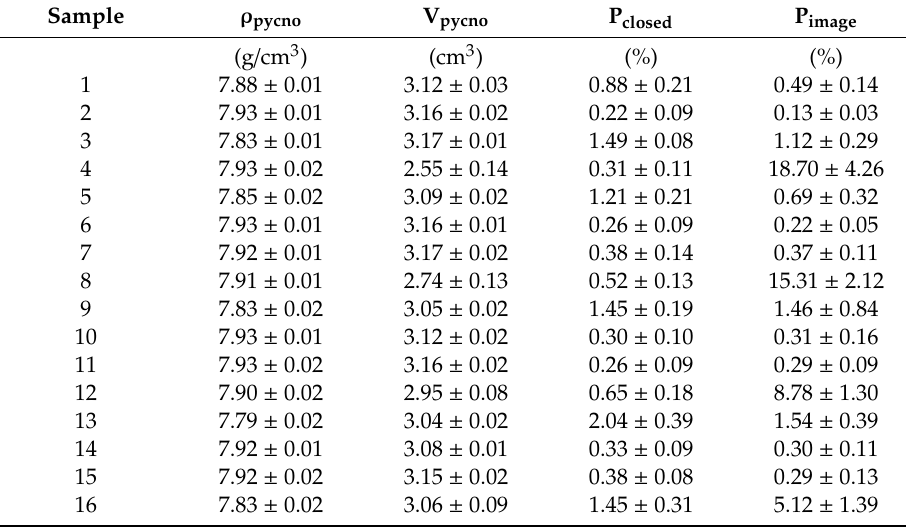
Table 2. Results of density measurements and porosity levels in samples after SLM.